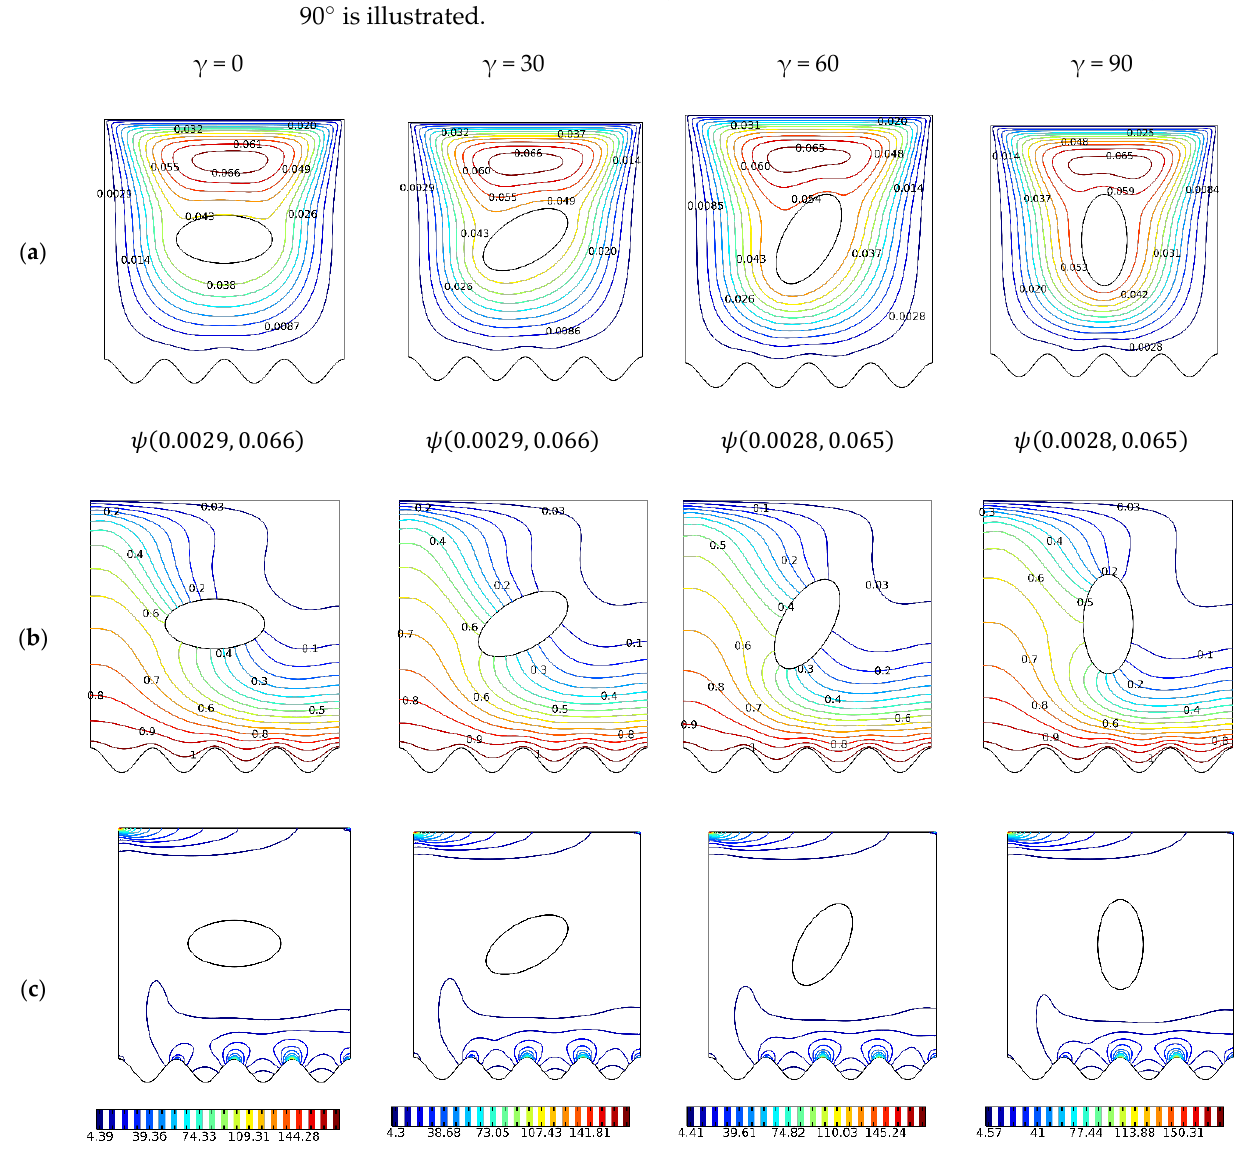
Figure 4. Streamlines, isotherms, and isentropic contours: γ : 0 ◦ ,30 ◦ ,60 ◦ ,90 ◦ ; N = 4; Ha = 0; Ri = 1; ϕ = 0.02. ( a ) ψ ; ( b ) Θ ; and ( c ) S.